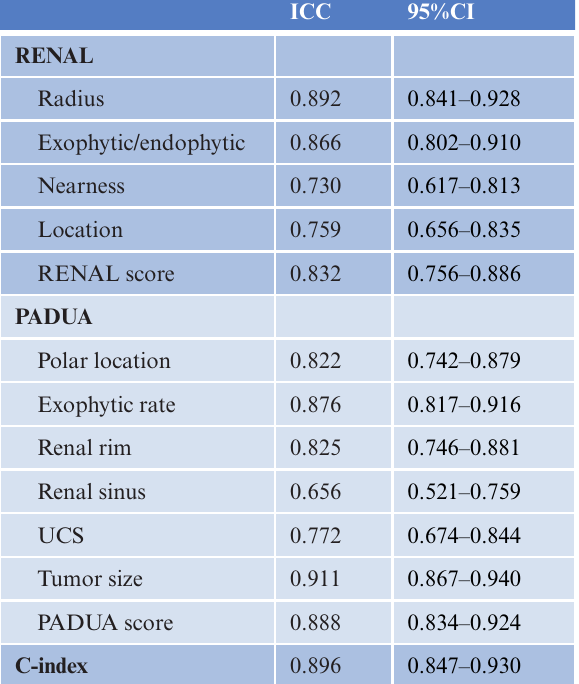
Table 7: Concordance between urologist’s and radiologist’s score using intraclass correlation